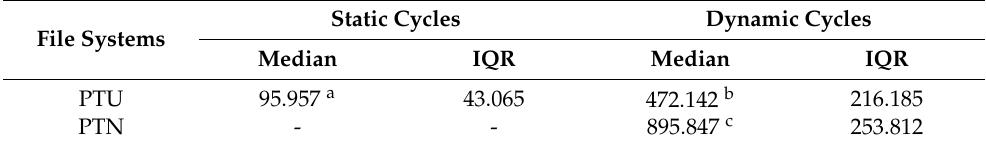
Table 2. Median and Interquartile Range (IQF) of NCF for the three experimental groups. File Systems